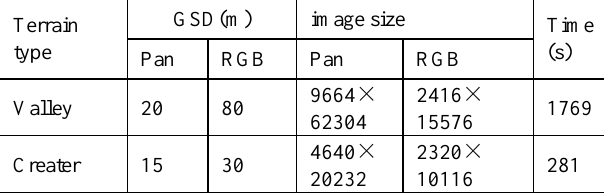
Table 2. The basic formation of test data